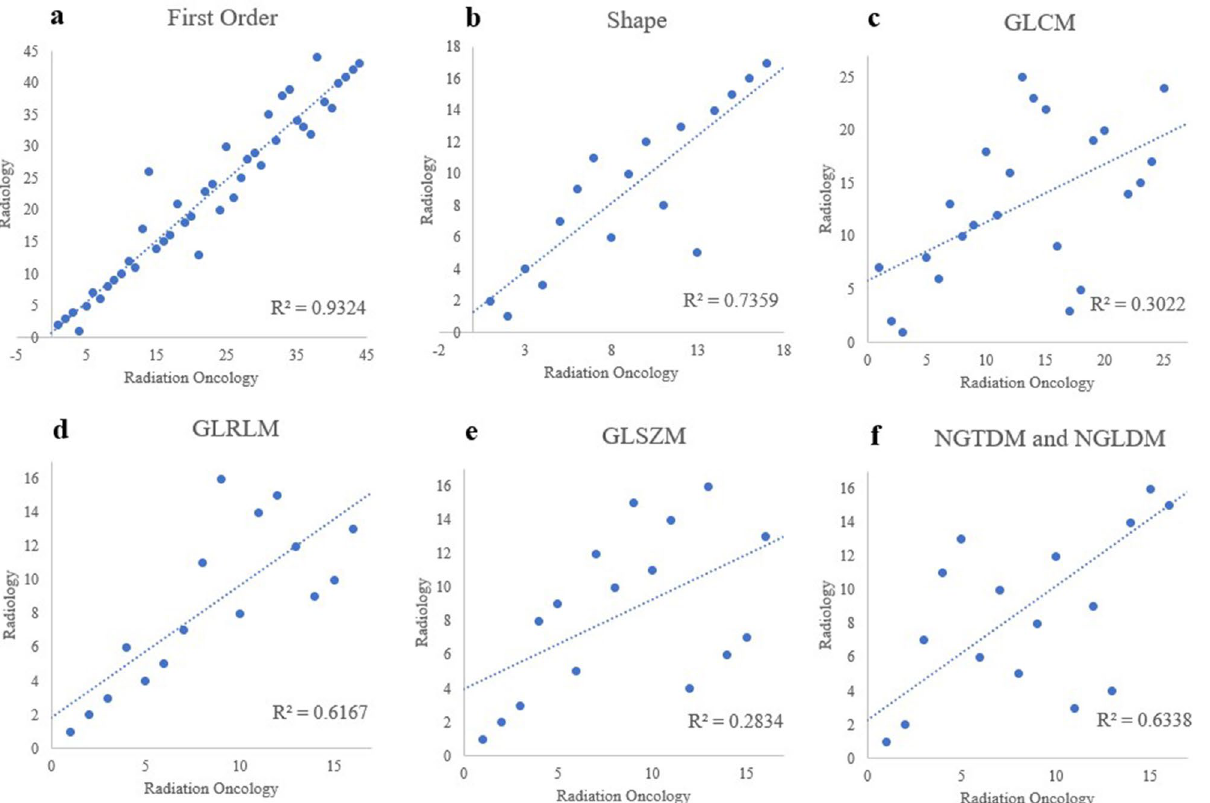
Figure 5. Ranked feature robustness. Features were ranked based on their relative robustness within each feature class for each discipline to indicate potential trends. A slope of 1 would suggest that the relative stability of features tend to be equivalent for both